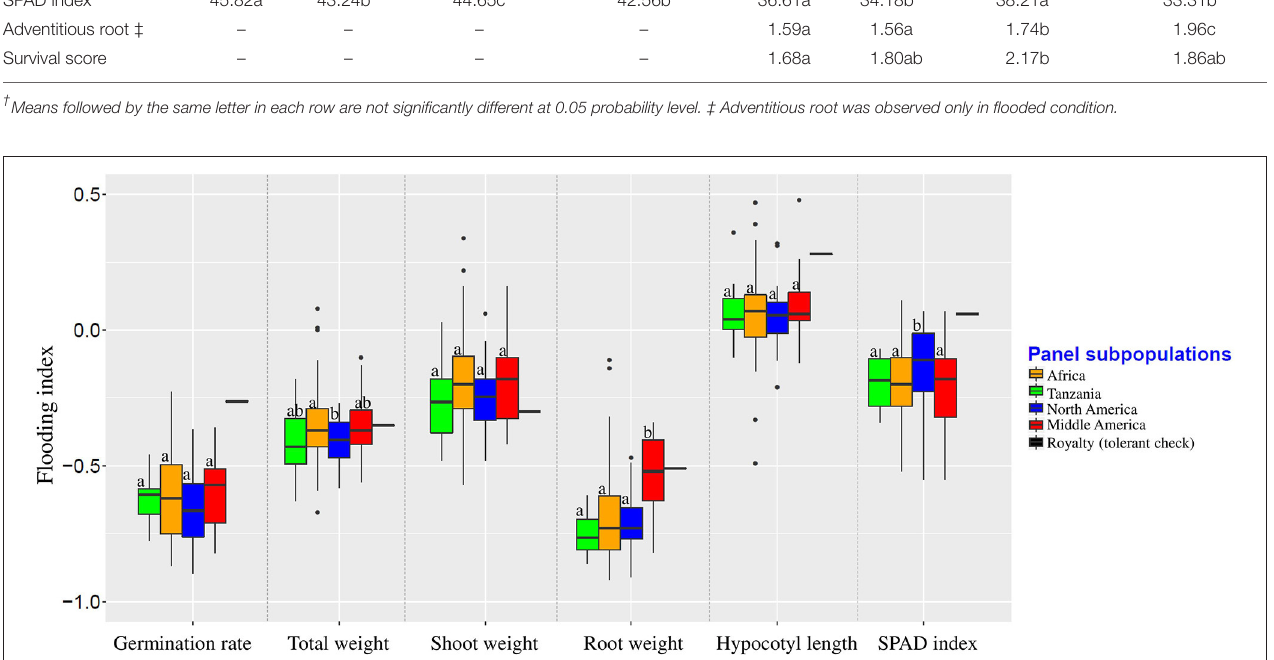
Frontiers in Plant Science |